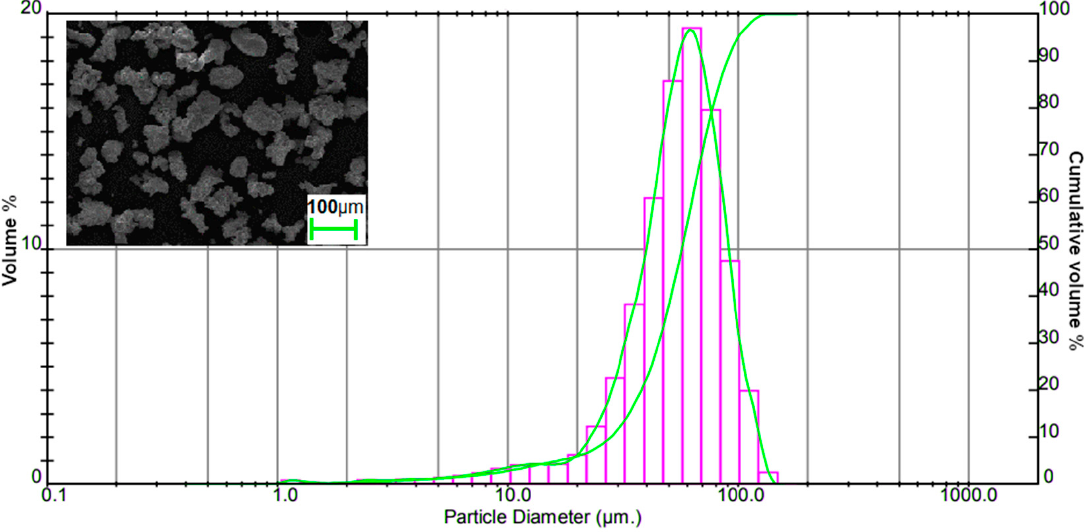
Figure 1. Particle size distribution and SEM micrograph of copper powder.